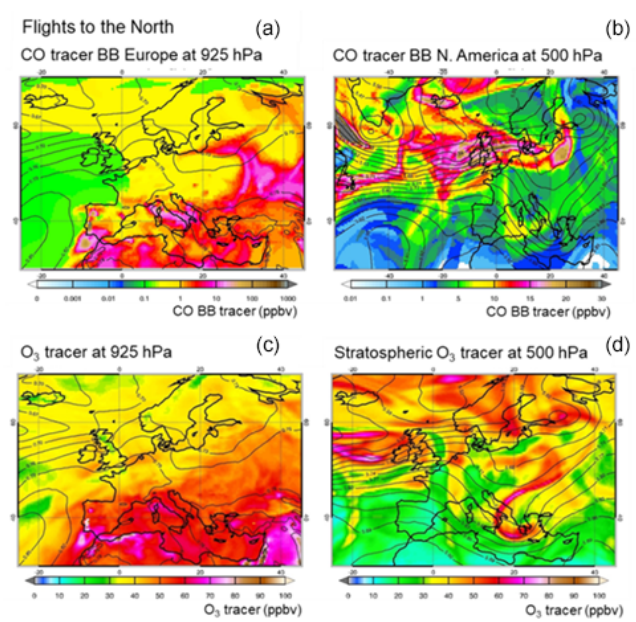
Figure 9. Coloured shadings of composite averages of CAMS global forecasts at 12:00UTC for flights to the north (E-EU-05, E-EU-08): BB CO tracer (ppbv) from Europe at 925hPa (a) and from North America at 500hPa (b) ; O 3 (ppbv) at 925hPa (c) and stratospheric ozone tracer (ppbv) at 500hPa (d) . Black contours show averages of geopotential height (km) from ECMWF IFS. Note the different scales. The BB tracer from North America (b) is shown on a larger map than the other CAMS forecasts in this image.